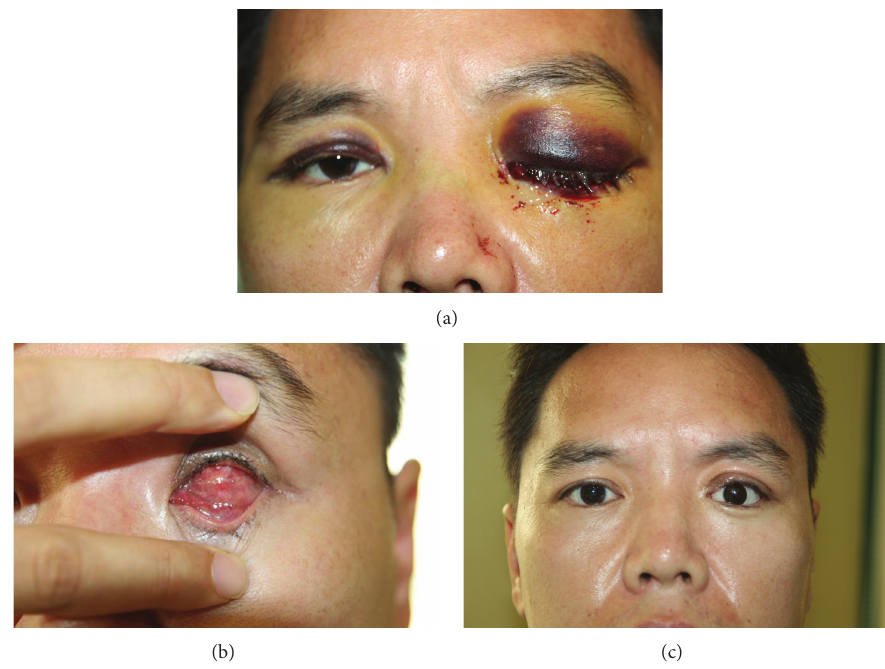
Figure 2: (a) Photograph taken on postoperative day 4. Severe upper eyelid swelling with ecchymosis and conjunctival prolapse through the palpebral fissure due to hemorrhagic chemosis. Note the eyelid ecchymosis extending to the contralateral eye. (b) Photograph taken on postoperative day 13 after infusion of the deficient factor. Good closure of the conjunctiva without chemosis or hemorrhage was observed. (c) Photograph taken on postoperative day 42 showing a well-fitted ocular